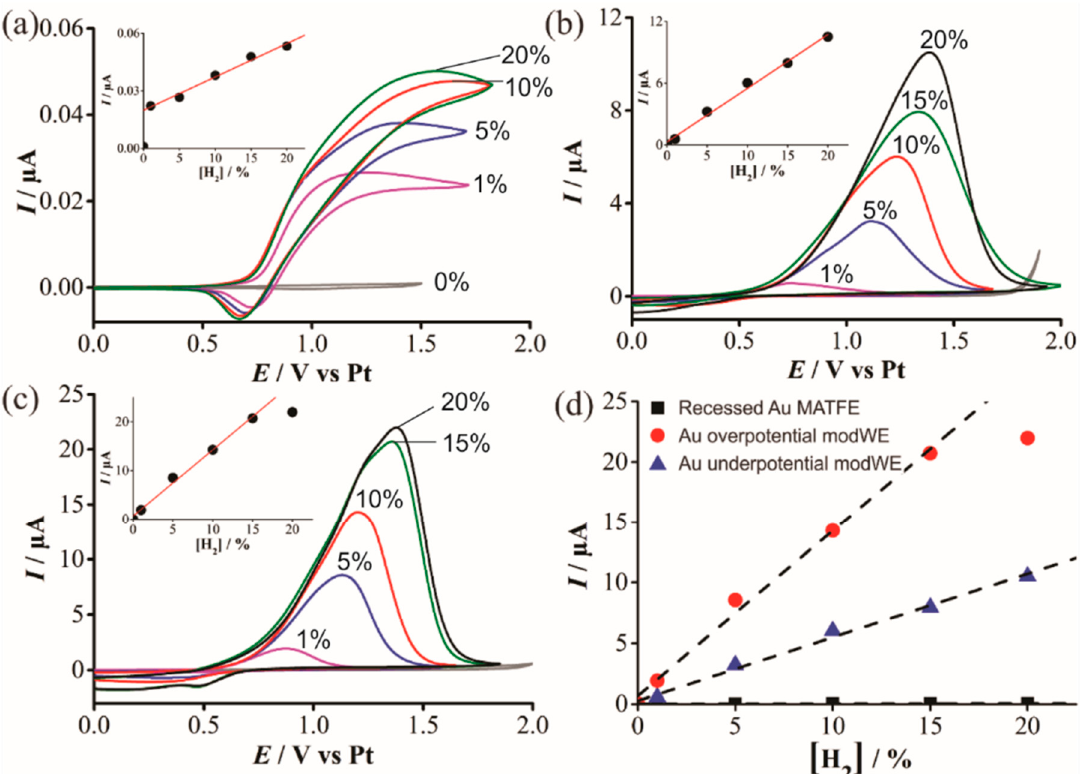
Figure 8. Cyclic voltammetry (CV) for the oxidation of H 2 (1%–20% vol. gas phase) in [C 4 mim] [NTf 2 ] on a ( a ) recessed Pt MATFE, ( b ) Pd overpotential modWE and ( c ) Pd underpotential modWE at a scan rate of 100 mVs − 1 . Grey line is the response in the absence of H 2 . The insets show background-subtracted calibration plots of peak current vs. concentration, along with the line of best fit. These calibration plots are overlaid in ( d ), showing the response on an unmodified Pt MATFE ( ■ ), Au overpotential modified Pt MATFE ( ● ), and Au underpotential modified Pt MATFE ( ▲ ).